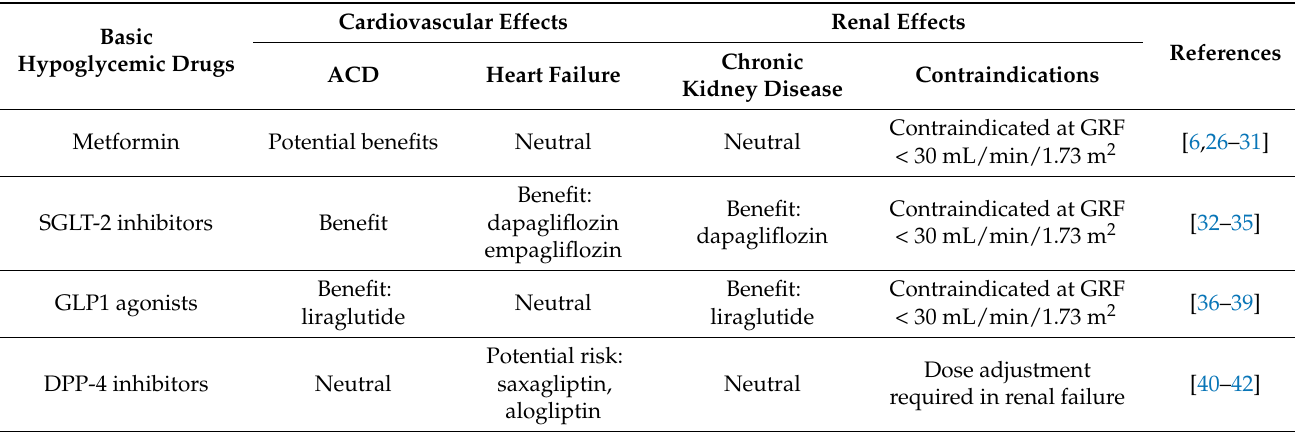
Table 1. Clinical factors in choosing the main hypoglycemic